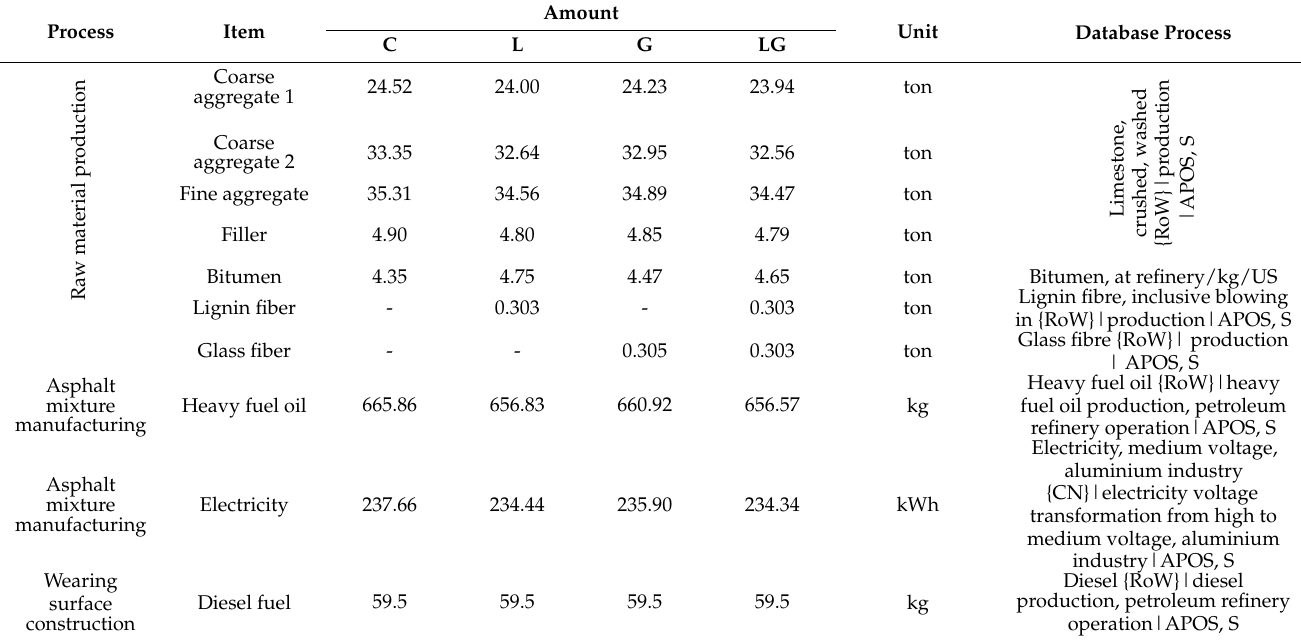
Table 5. LCI for all processes and mass balance for the studied asphalt